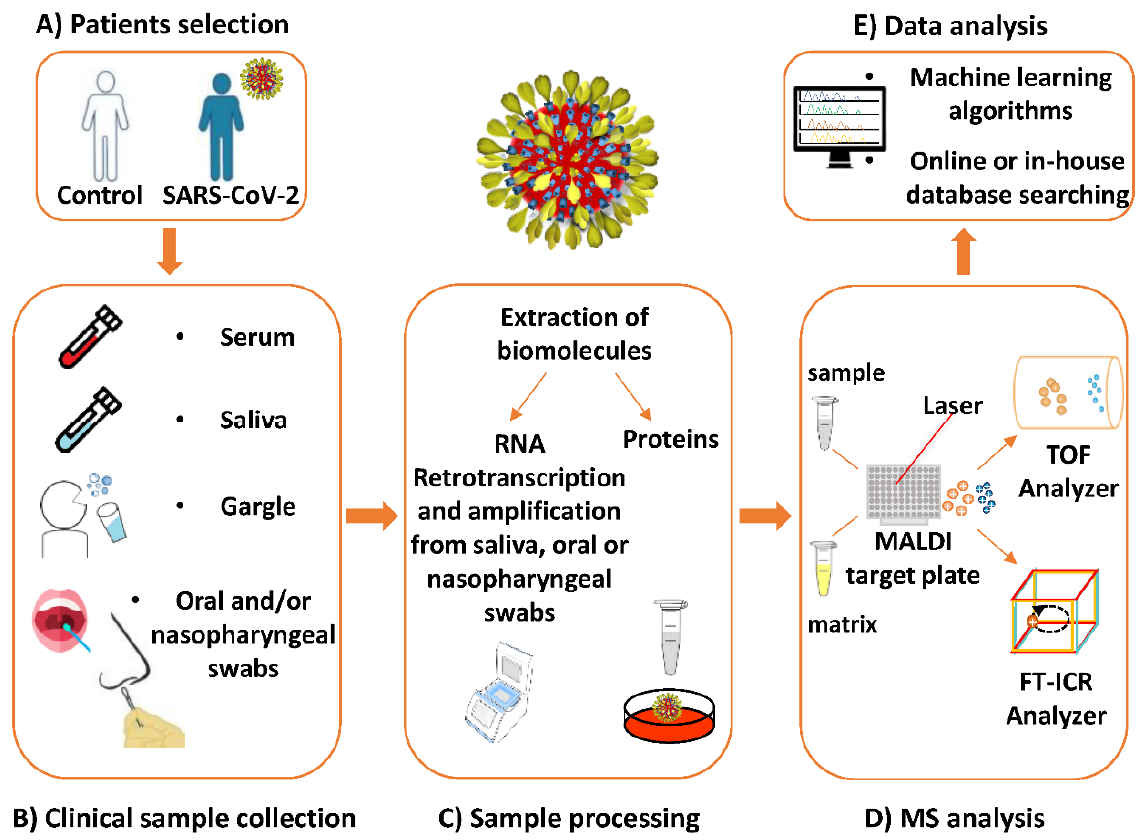
Figure 3. Workflow of main MALDI MS-based investigations targeting SARS-CoV-2. ( A ) Control subjects and (PCR-diagnosed) SARS-CoV-2 patient enrollment. ( B ) Clinical sample (serum, saliva, gargle, oral, and/or nasopharyngeal swab) collection from control subjects and SARS-CoV-2 patients. ( C ) Sample processing based on the extraction of RNA or proteins. RNAs are retro-transcripted and amplified from saliva, oral, and/or nasopharyngeal swabs in genotyping methods; proteins are extracted from body fluid samples or from cell-cultured SARS-CoV-2 samples in the proteotyping and biotyping methods; in the case of biomolecular host profiling methods, proteins are extracted from bodily fluids. ( D ) MS analysis based on the ionization in a MALDI source and the separation of the ions into two different types of analyzers: TOF and FT-ICR. ( E ) Data analysis using online or in-house database searching or machine learning algorithms for the detection of SARS-CoV-2 infection.